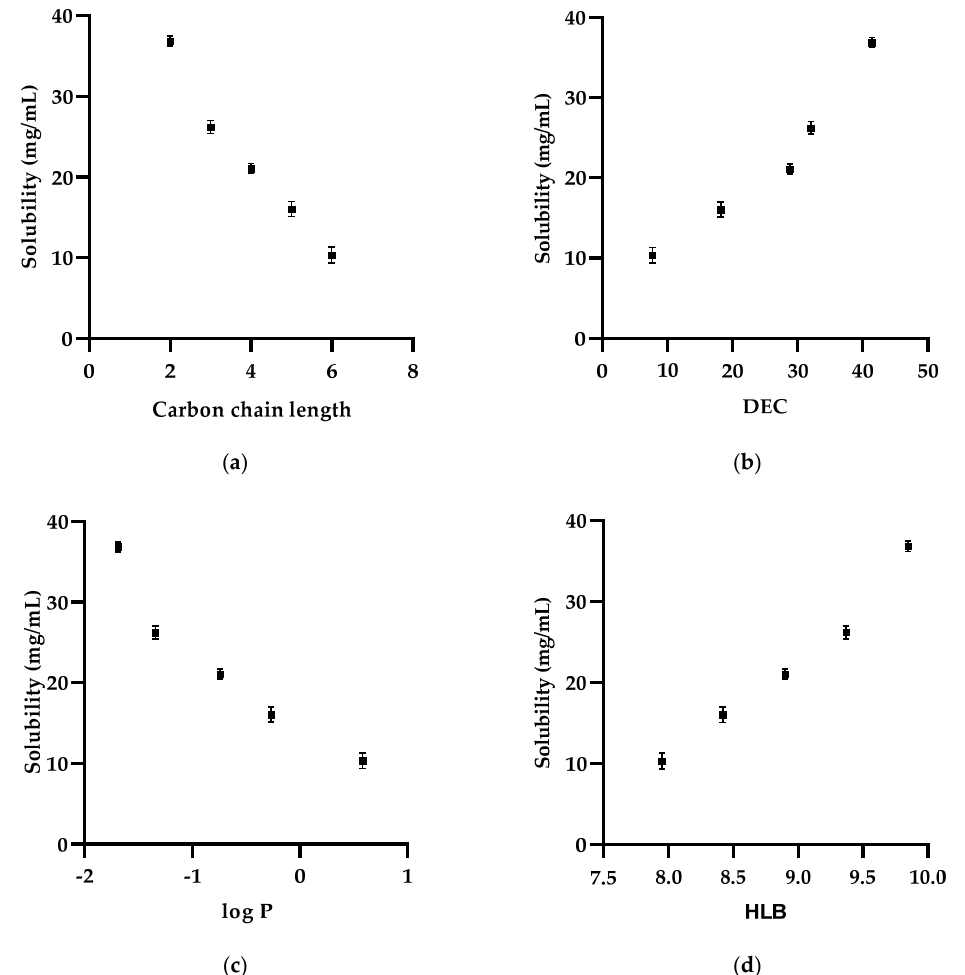
Figure 2. The dependency of KT solubility on ( a ) carbon chain length, ( b ) dielectric constant ( c ) log P, and ( d ) HLB of the diol cosurfactant (ethylene, propylene, butylene, pentylene, and hexylene glycols). Results are expressed as the mean ± SD, n = 3.